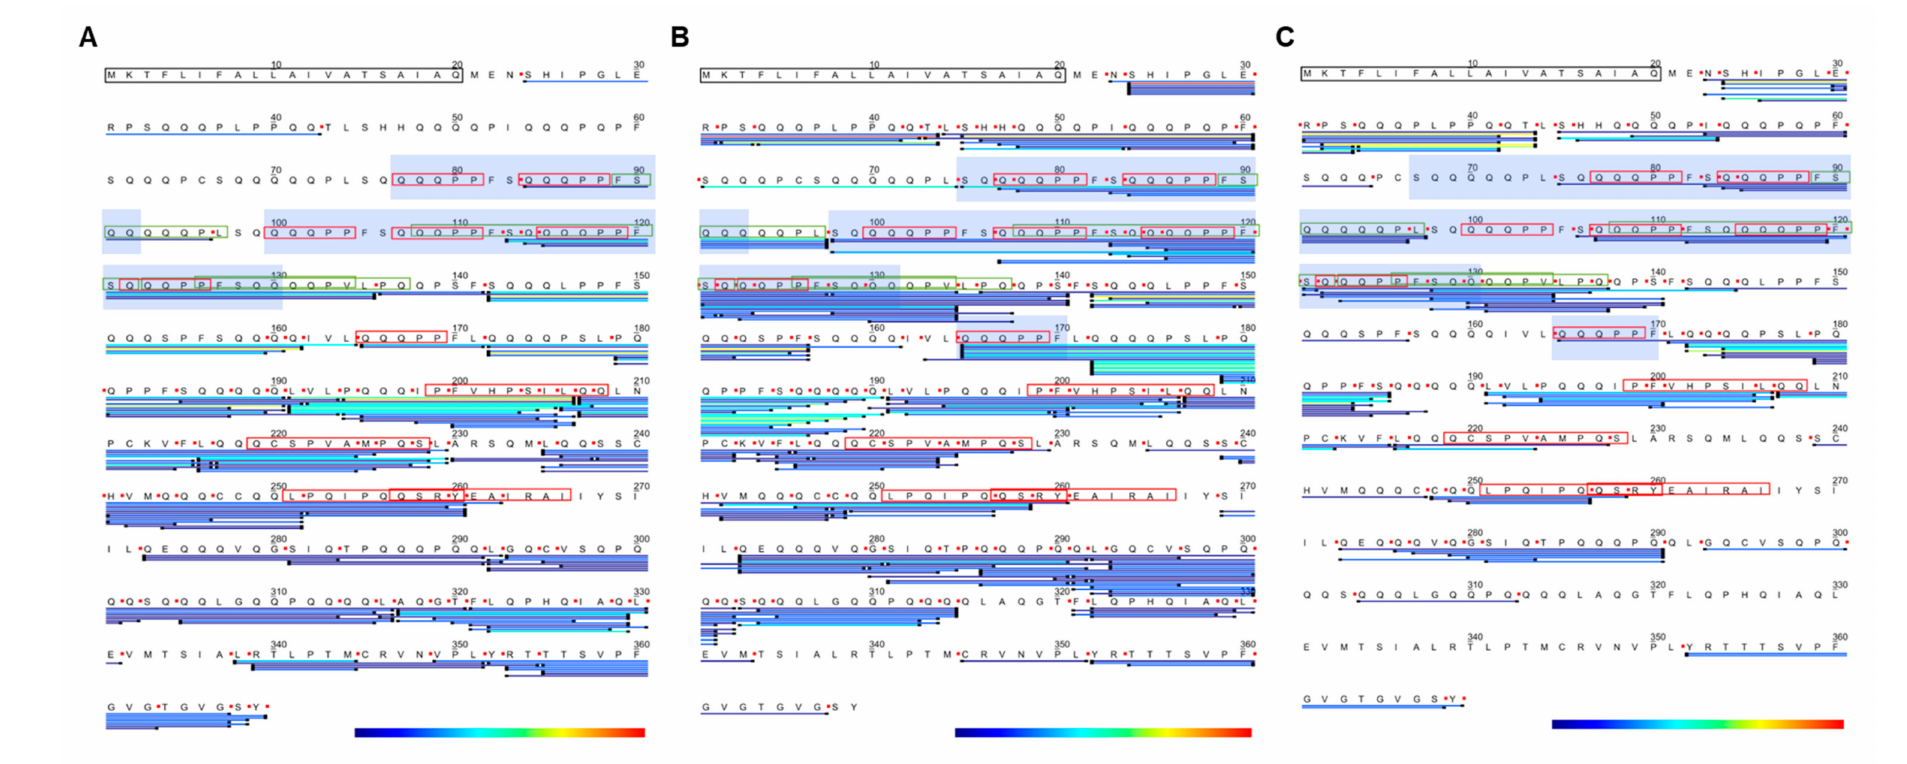
Figure 6. Peptide mapping of the LMW-GS allergen B2Y2Q7 throughout simulated digestion. Identified peptides were mapped onto the parent protein B2Y2Q7 at timepoints G60 ( A ), D0 ( B ) and D120 ( C ). The sequences bounded by a black box indicate the signal sequence, and those bounded in red and green represent IgE epitopes and coeliac toxic motifs, respectively. The domains with consensus repetitive peptides are shown in blue boxes. Endoprotease cleavage sites are denoted by red dots. Only the G60 digest is shown since it was similar to the G120 digest (Supplementary Figure S3A). Colour shading represents relative abundance of peptides calculated using spectral counting with the gradient from blue to red indicating increasing